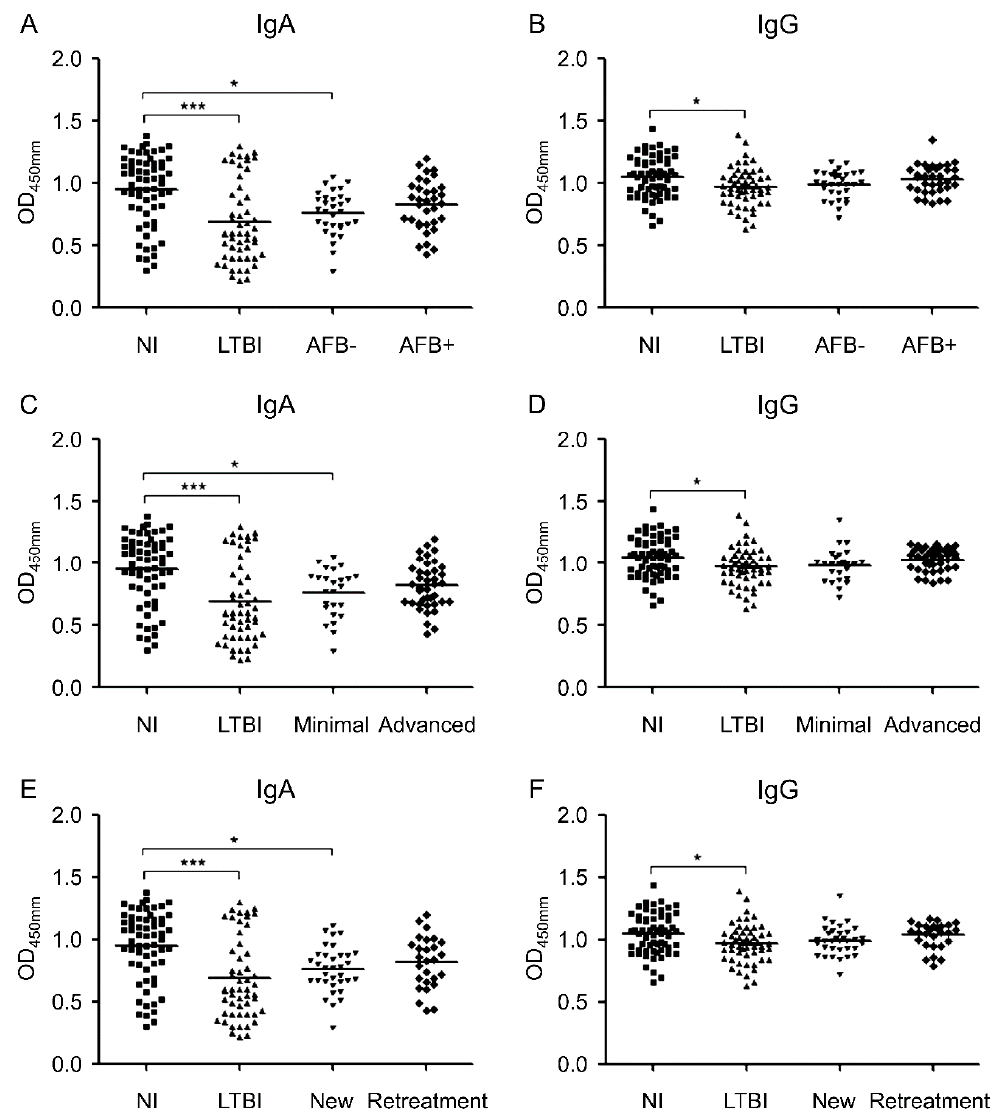
Figure 3. Optical density (OD) values of the anti-macrophage migration inhibitory factor (MIF) immunoglobulin (Ig)A ( A ) and anti-MIF IgG ( B ) serodiagnostic assays for the comparison of 31 acid-fast bacilli (AFB)-negative tuberculosis (AFB-) patients, 34 AFB-positive tuberculosis (AFB+) patients, 53 latent tuberculosis infection (LTBI) patients, and 62 non-infected (NI) individuals. OD values of the anti-MIF IgA ( C ) and anti-MIF IgG ( D ) serodiagnostic assays for the comparison of 25 minimal tuberculosis patients, 40 advanced tuberculosis patients, 53 LTBI patients, and 62 NI individuals. OD values of the anti-MIF IgA ( E ) and anti-MIF IgG ( F ) serodiagnostic assays for the comparison of 34 new patients, 27 retreatment patients, 53 LTBI patients, and 62 NI individuals. Each dot represents the values obtained from individual subjects; horizontal bars indicate the mean values. Groups were compared using one-way ANOVA with Bonferroni’s multiple comparisons. * p < 0.05; *** p <